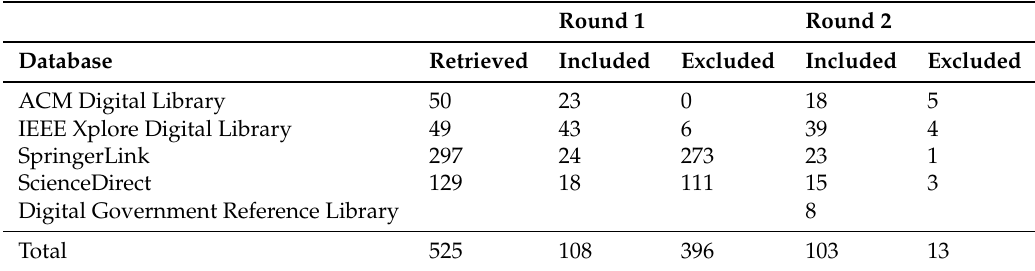
Table 2. Number of identified studies throughout the different rounds of our systematic search. Round